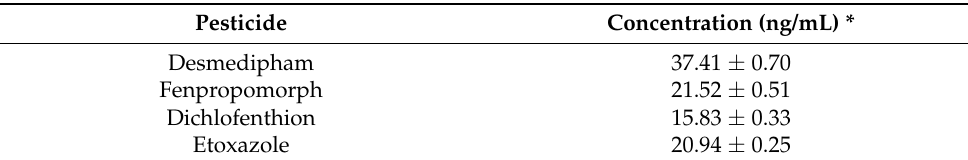
Table 3. LC-MS-MS analysis of pesticide in the propolis.